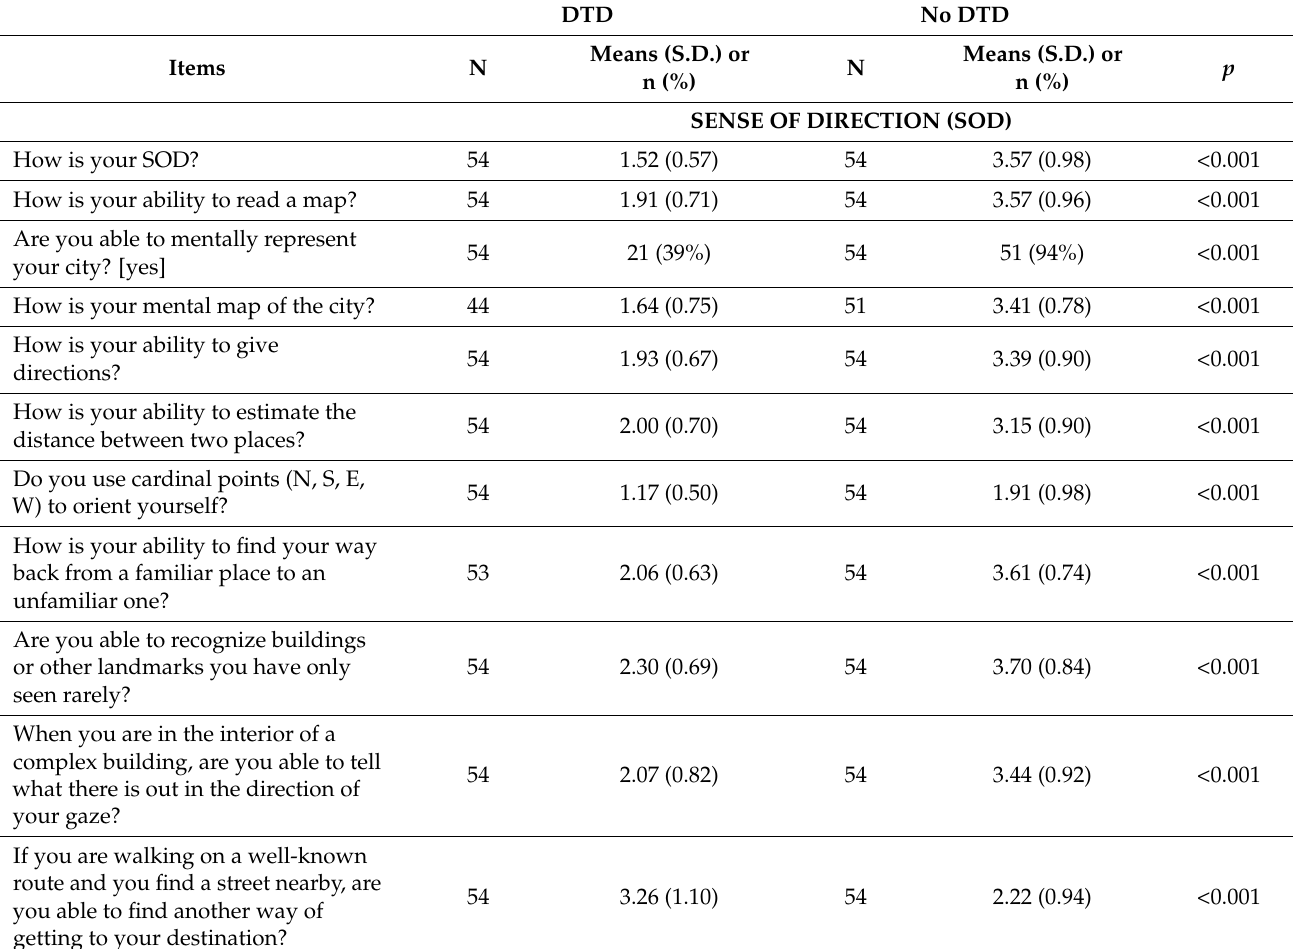
Table 1. Means and S.D. of each item of FCSQ